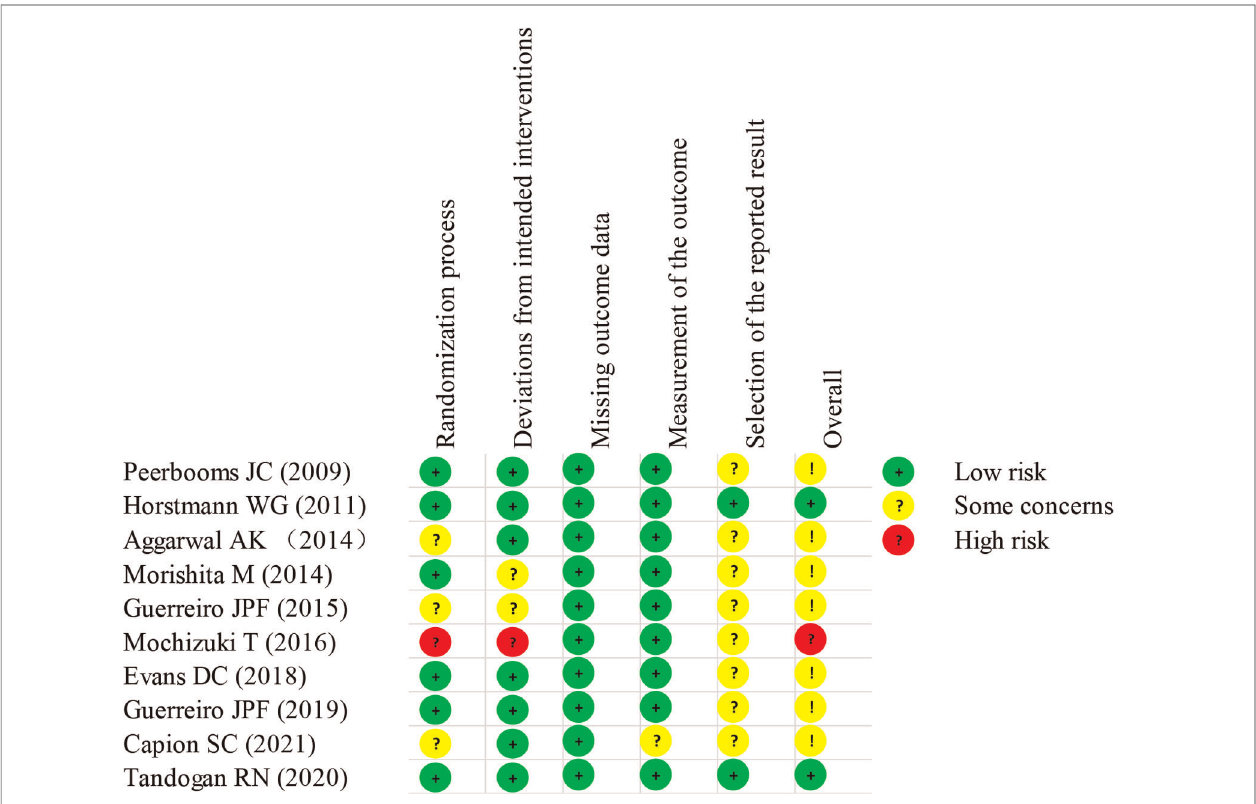
FIGURE 2 | Risk of bias assessment of the included